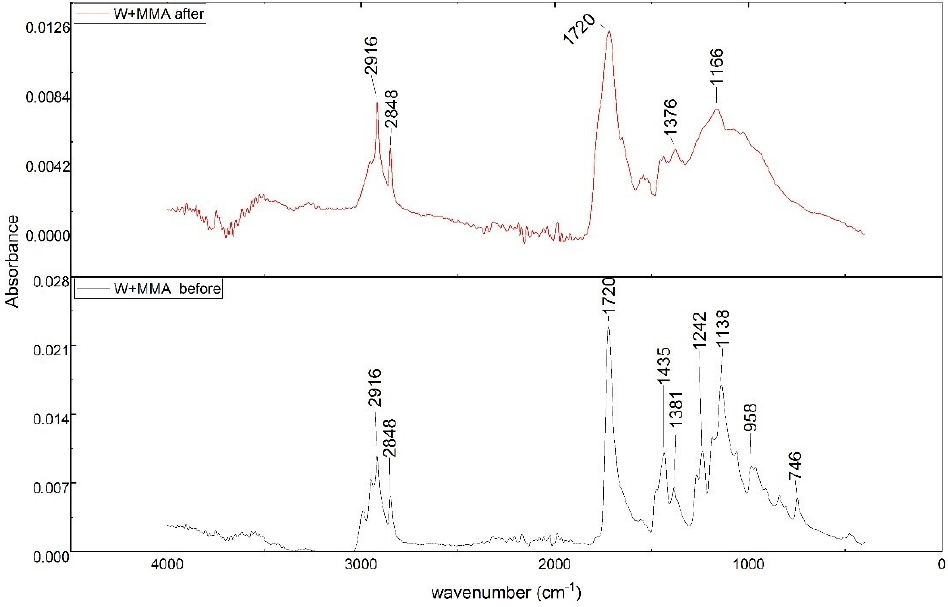
Figure 6. Changes to the chemical structure of W+EMA and W+MMA samples before and after the UV-C irradiation.